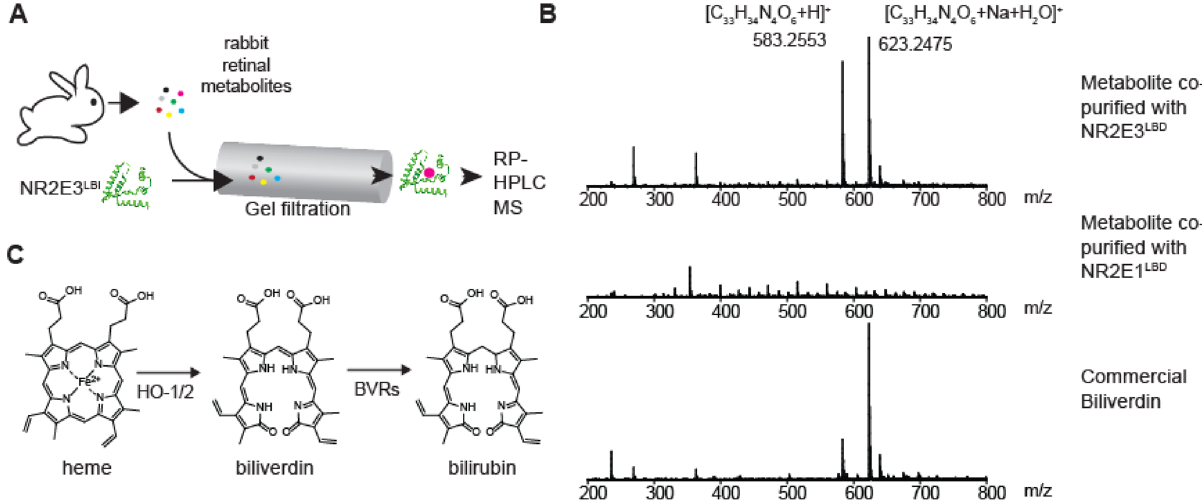
Figure 1. Identification of biliverdin as a potential NR2E3 LBD ligand. ( A ) A schematic representation of the method. Small molecules extracted from rabbit retina were incubated with recombinant MBP-NR2E3 LBD expressed and purified from E. coli . Protein-bound small molecules were isolated by a gel filtration chromatography and identified by mass spectrometry. ( B ) Mass spectra (ESI, positive ions) of